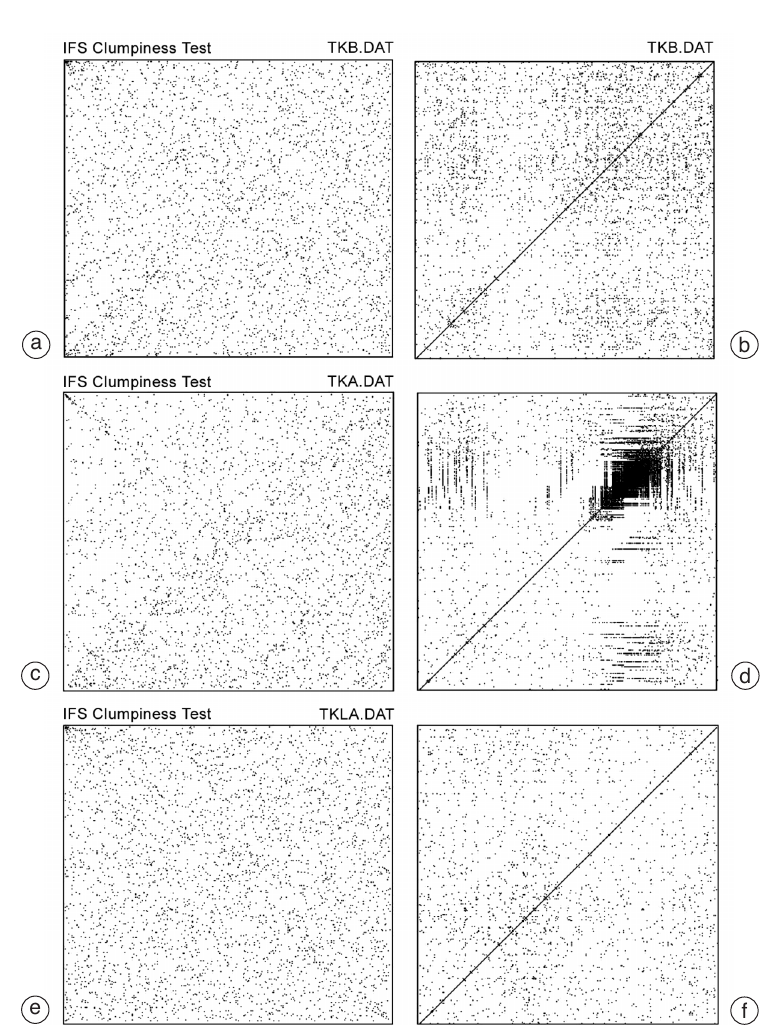
Fig. 9a-f. Qualitative analysis of temporal distribution of earthquakes including small events (whole catalogue, all events) before beginning of EM experiments (1975-1983), during experiments (1983-1988) and after accom- plishing of experiments (1988-1992). IFS-clumpiness test for waiting times sequences: a) before experiments; c) during experiments; e) after experiments. Recurrence plots analysis of inter-event time interval sequences: b) before experiments; d) during experiments; f) after